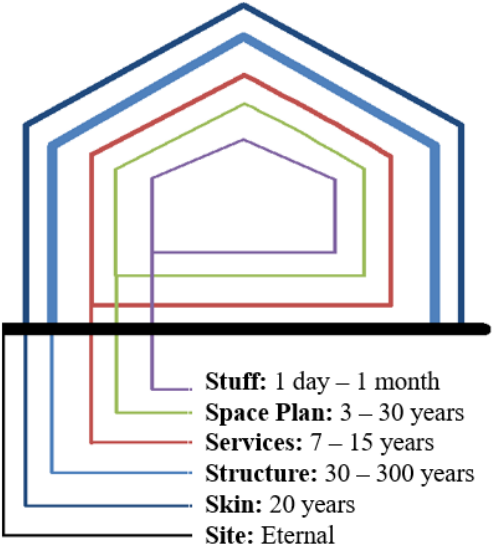
Figure 1. Six shearing layers of a structure and their lifetimes (adapted from Reference [5], Penguin, 1995).